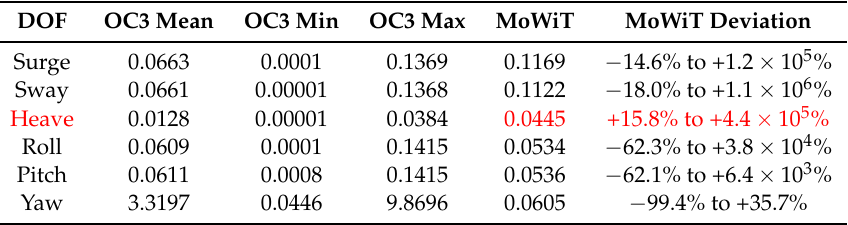
Table 10. Damping ratios from OC3 and MoWiT in comparison, deviations are highlighted in